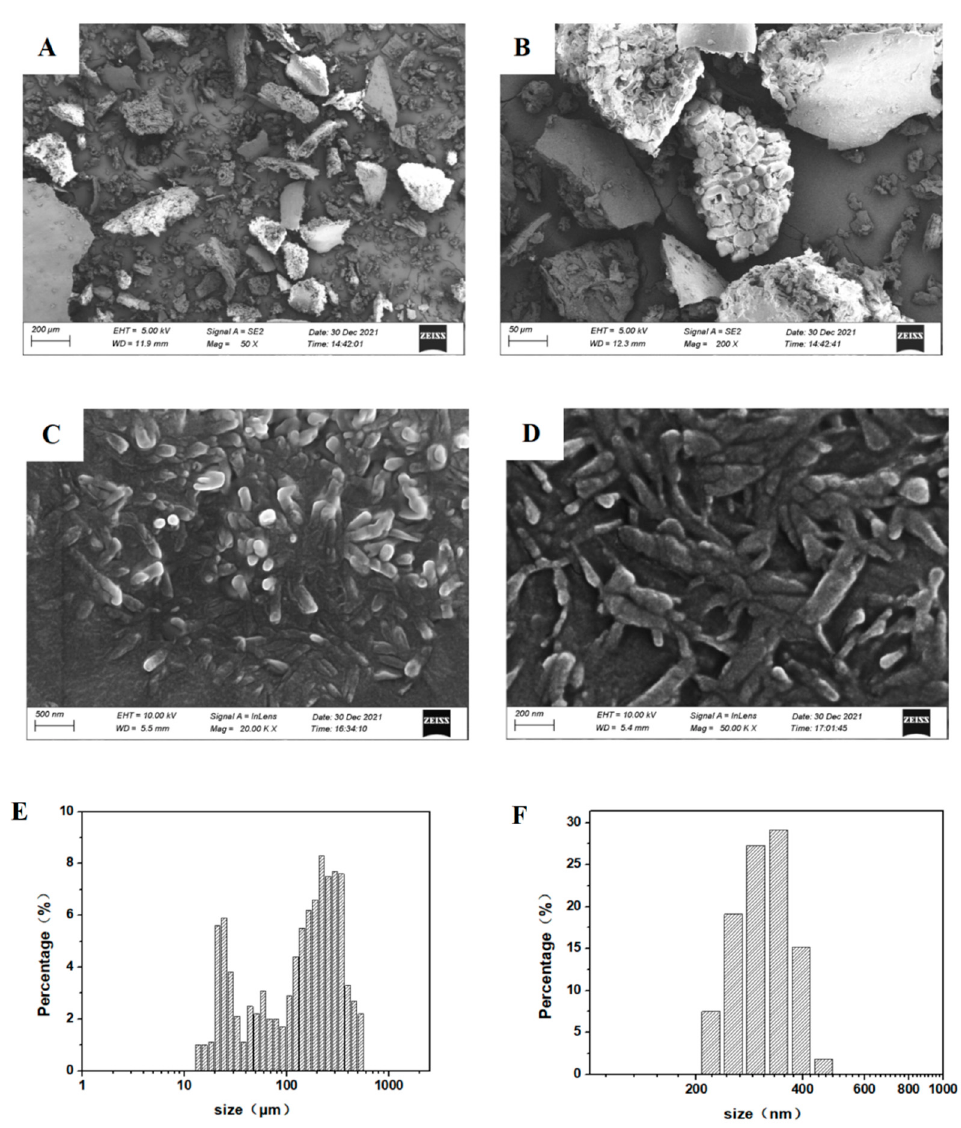
Figure 5. SEM detection chart and particle size distribution of the ( A , B ) crude Taxus cuspidata and ( C , D ) the recrystallized product of Taxus cuspidata ; ( E ) particle size distribution diagram of the crude Taxus cuspidata ; ( F ) grain size distribution diagram of the recrystallized product.